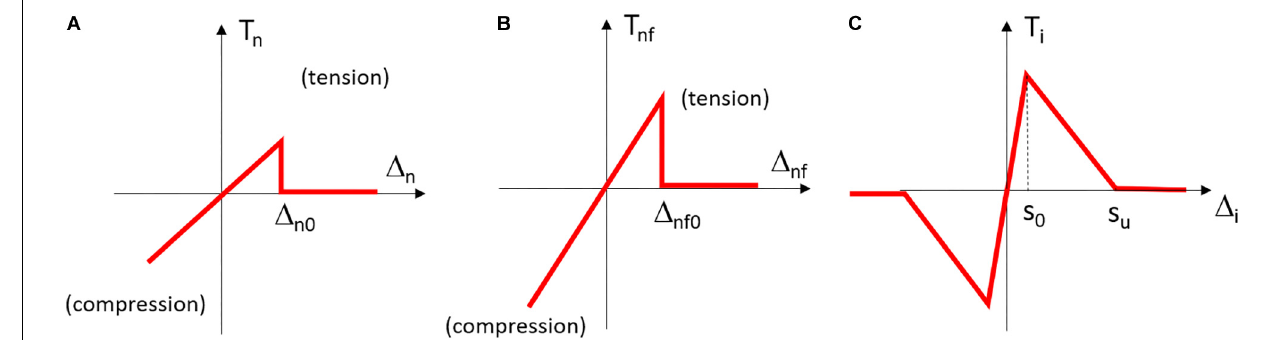
FIGURE 4 | Constitutive laws introduced for the springs: (A) matrix-spring; (B) reinforcement-spring; (C) reinforcement-matrix spring.